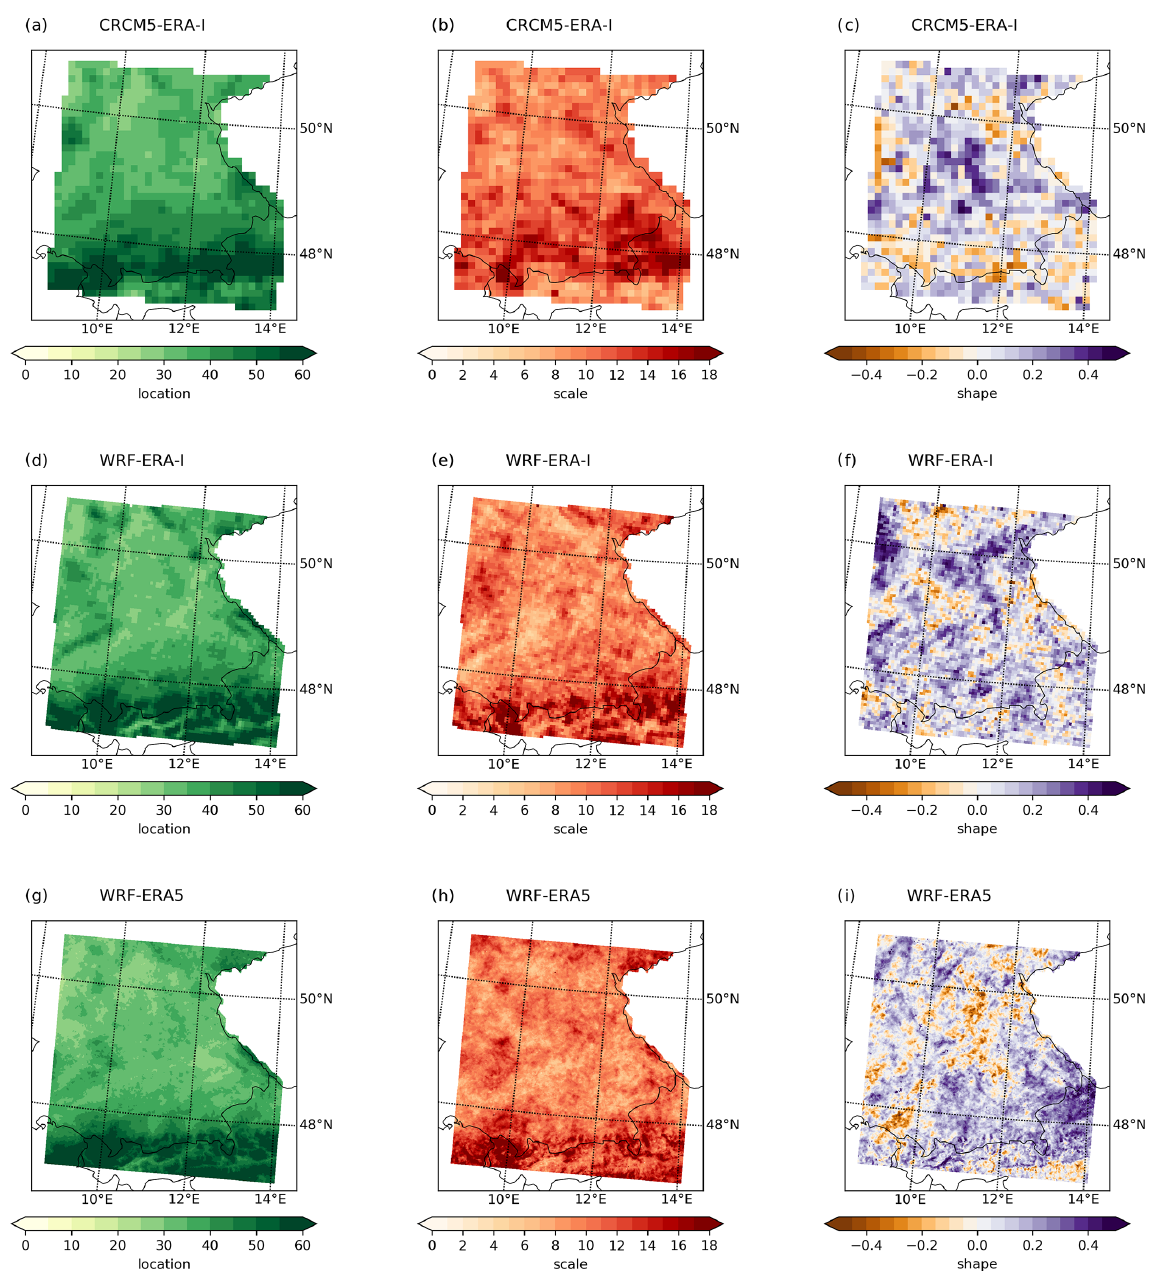
Figure 3. Location, scale, and shape parameters of the GEV-LMOM approach based on CRCM5 ERA-Interim (a–c) , WRF ERA-Interim (d– f) , and WRF ERA5 (g–i)